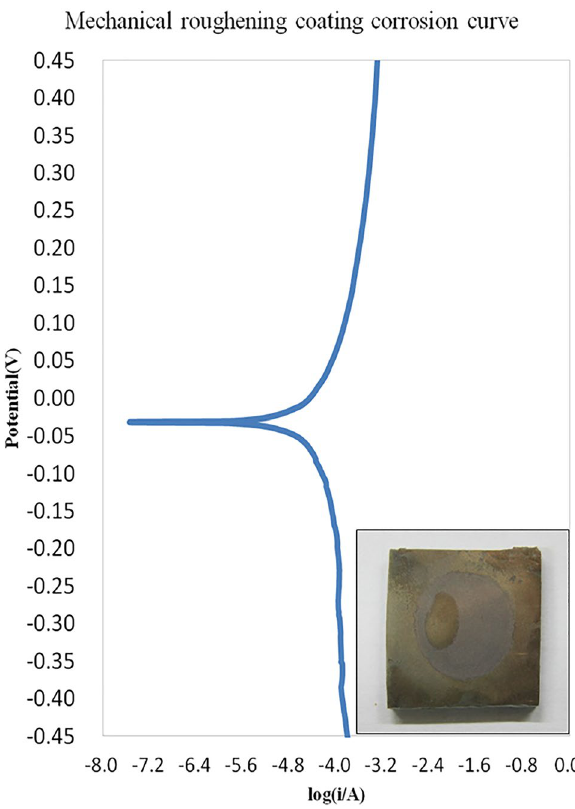
Figure 12. Electrochemical corrosion of Gold-coated on PMMA bipolar plate.